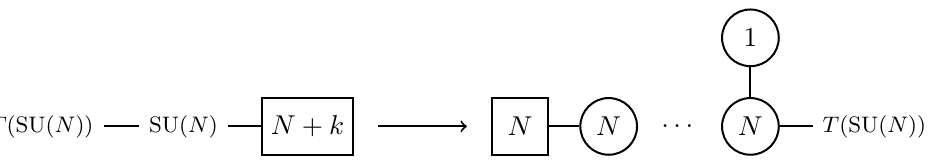
Figure 2. The N = 4 mirror pair used in [10] to extract the dual description of N = 2 SQCD. The number of U( N ) gauge groups in the mirror quiver on the right is k